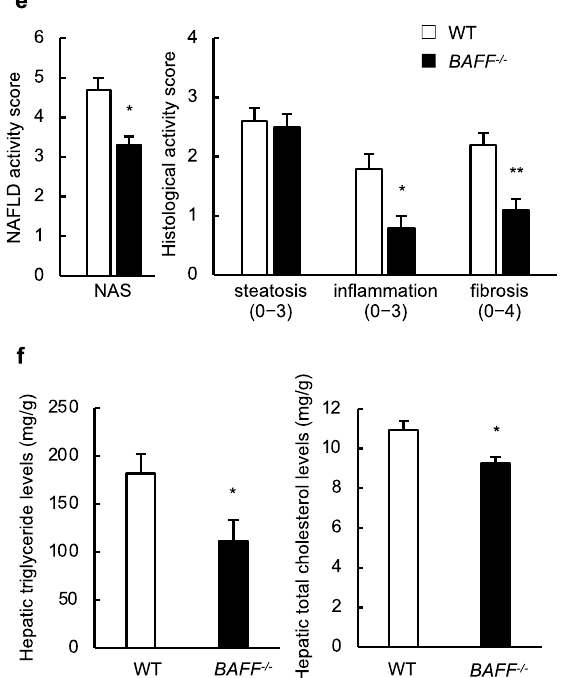
Figure 1. BAFF deficiency attenuates liver steatosis in murine models of non-alcoholic steatohepatitis (NASH). ( a ) Experimental protocol of the new NASH mouse model using HFHCD/CCl 4 -induced liver injury. Six-week-old mice, WT mice and BAFF − / − mice, were fed with HFHCD. They received intraperitoneal (i.p.) injections of CCl 4 at a dose of 0.4 mL/kg (diluted 1:25 in olive oil), twice a week for 4 weeks from 9 weeks age; ( b ) Liver weight: (liver weight/body weight) × 100% from WT and BAFF − / − mice treated with HFHCD/CCl 4 ( n = 15/group); ( c ) Serum AST and ALT levels of WT and BAFF − / − mice treated with HFHCD/CCl 4 ( n = 8/group); ( d ) Representative OsO 4 fixtation (left) and quantification of the OsO 4 -positive area (right) of liver from HFHCD/CCl 4 -treated WT and BAFF − / − mice (scale bar, 100 µ m; images from 8 different fields; n = 5/group); ( e ) NAFLD activity score and fibrosis stage of HFHCD/CCl 4 -treated WT and BAFF − / − mice ( n = 10/group); ( f ) The levels of hepatic triglyceride (left) and total cholesterol (right) of WT and BAFF − / − mice treated with HFHCD/CCl 4 ( n = 6/group). For all bar plots shown, data represent mean ± standard error of the mean. * p < 0.05 and ** p < 0.01. BAFF, B cell-activating factor; HFHCD,